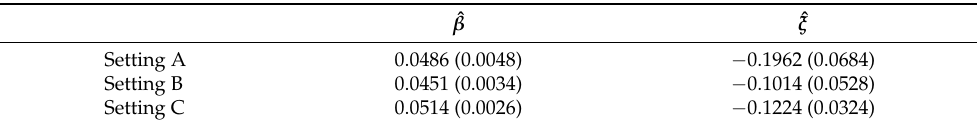
Figure A4. Autocorrelation functions and periodogram of the ARFIMA residuals for the simulated settings A, B and C. Table A2. Estimation results of the GPD fit to the ARFIMA ( p , d , q ) residuals for the simulated settings A, B, and C. Standard errors in